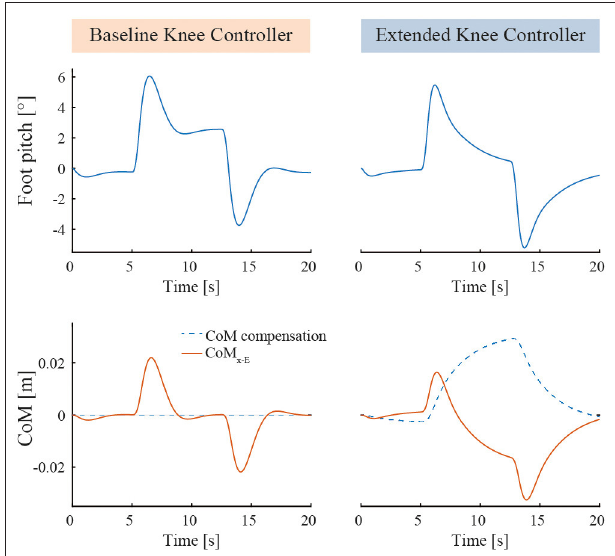
FIGURE 3 | Simulation results comparing BKC (with PID) and EKC when subject to a constant horizontal perturbation force. The horizontal pushing perturbation starts at t = 5s, stops at t = 13s, has an intensity of 20N and a ramping time of